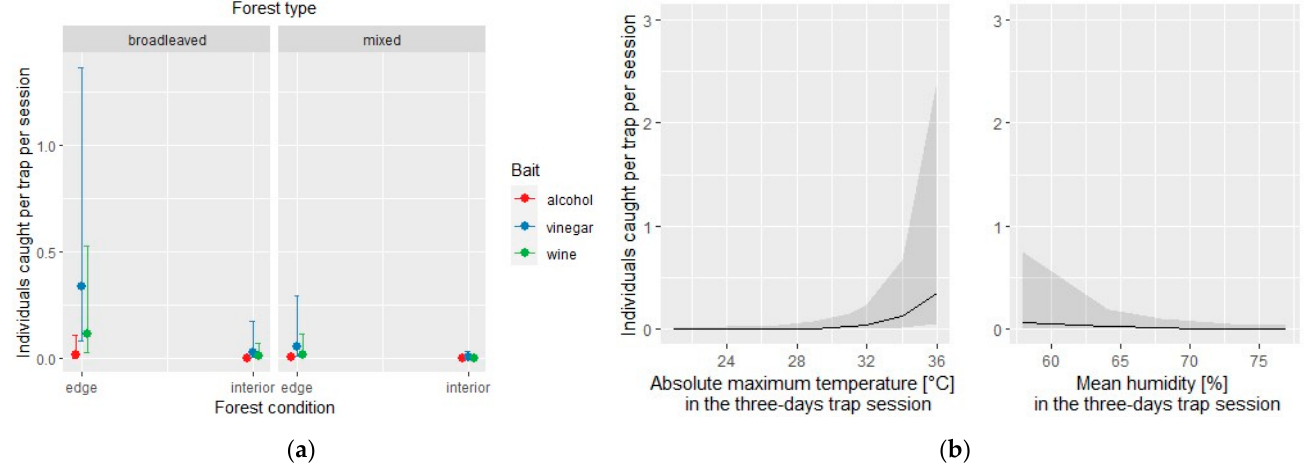
Figure 5. Popillia japonica : effect of the covariates of the negative binomial regression model affecting the number of individuals caught by each of the three traps per site and per session; ( a ) conditional effect of habitat covariates (forest type: broadleaved vs. mixed; forest condition: edge vs. interior); ( b ) main effect of meteorological covariates. Table 7. Epuraea ocularis . Effectiveness of baits in attracting individuals of the species, accounting for the effects of habitat and meteorological covariates considered in the negative binomial regression model.